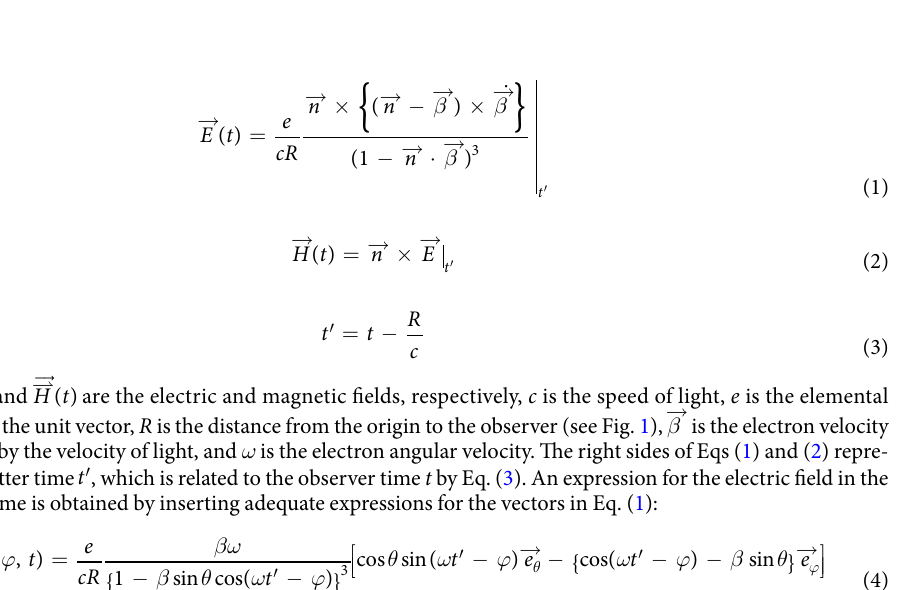
Figure 1. Coordinate system. The electron is rotating in the x-y plane around the origin with an initial position on the x-axis. The azimuthal angle of the position of the observer is measured from the y-axis. The observer frame is defined as a spherical